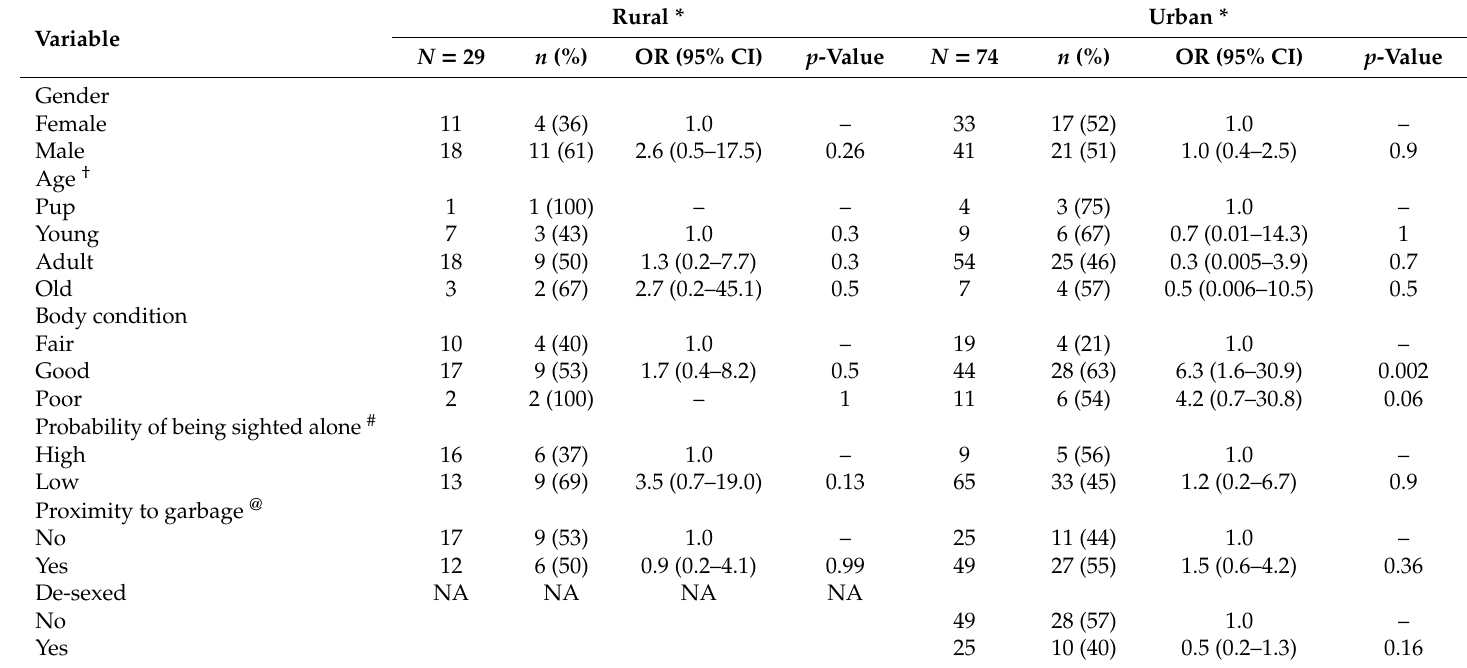
Table 6. Test of association between dichotomised home-range * and predictor variables for the rural (Shirsuphal) and urban (Panchkula) locations.